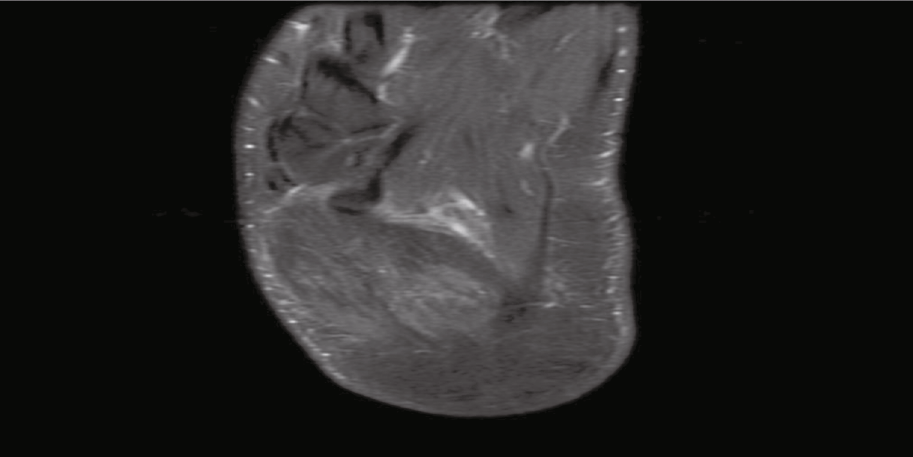
Figure 5: Axial T1 images post contrast demonstrating ill-de fi ned heterogeneous enhancement of the abductor digiti minimi muscle, with no wall (ring) enhancement.